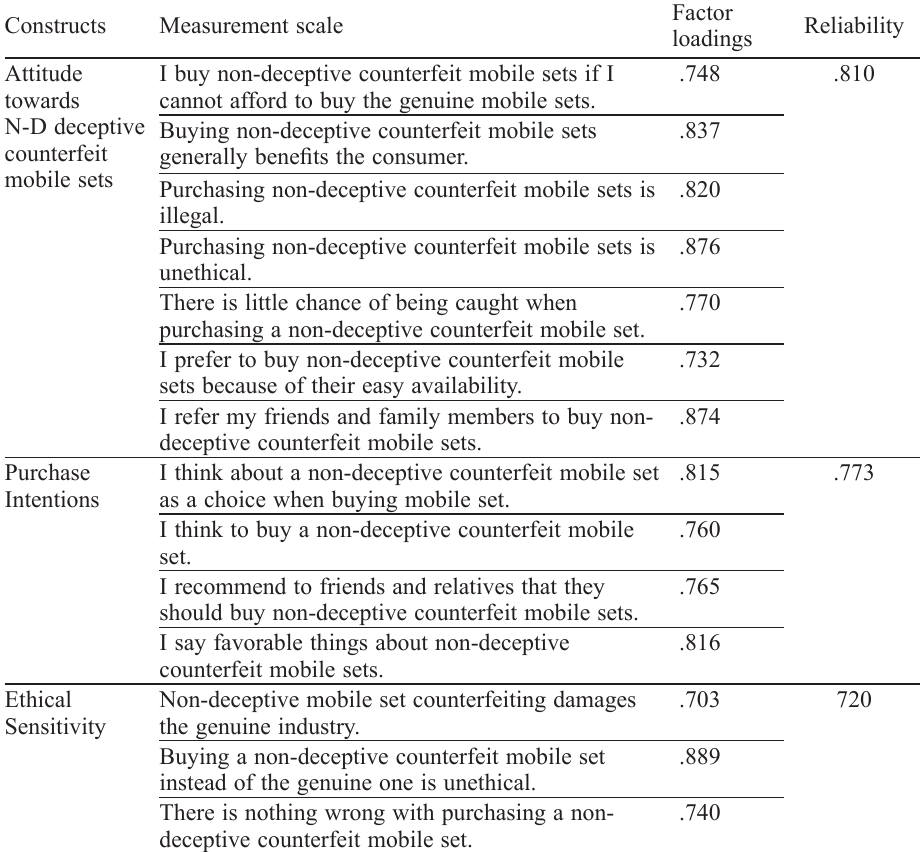
Table 1 . Measurement scales of the study